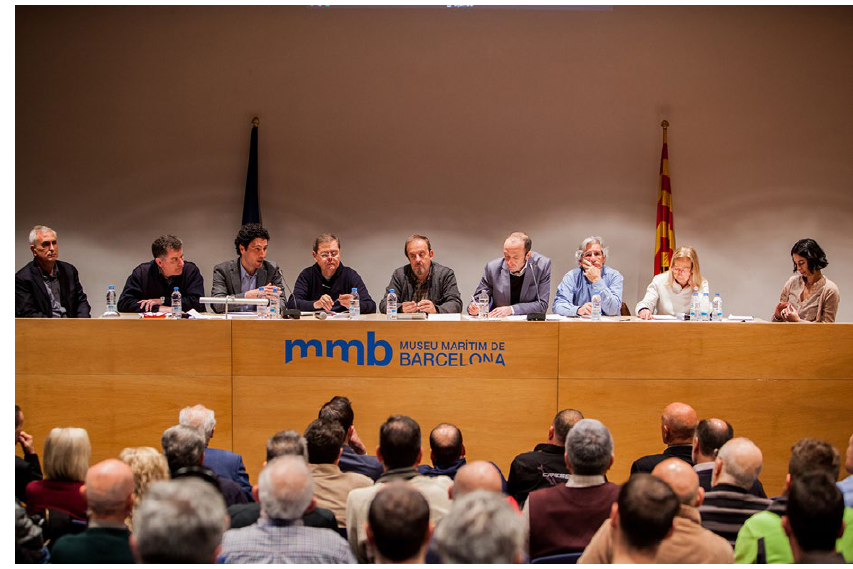
Fig. 2 – Discussion and approval of the Barcelona Agreement at the Maritime Museum of